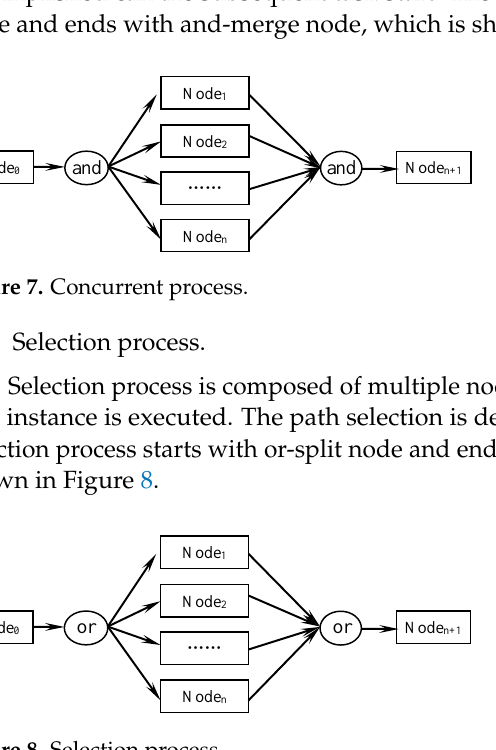
Figure 8. Selection process.